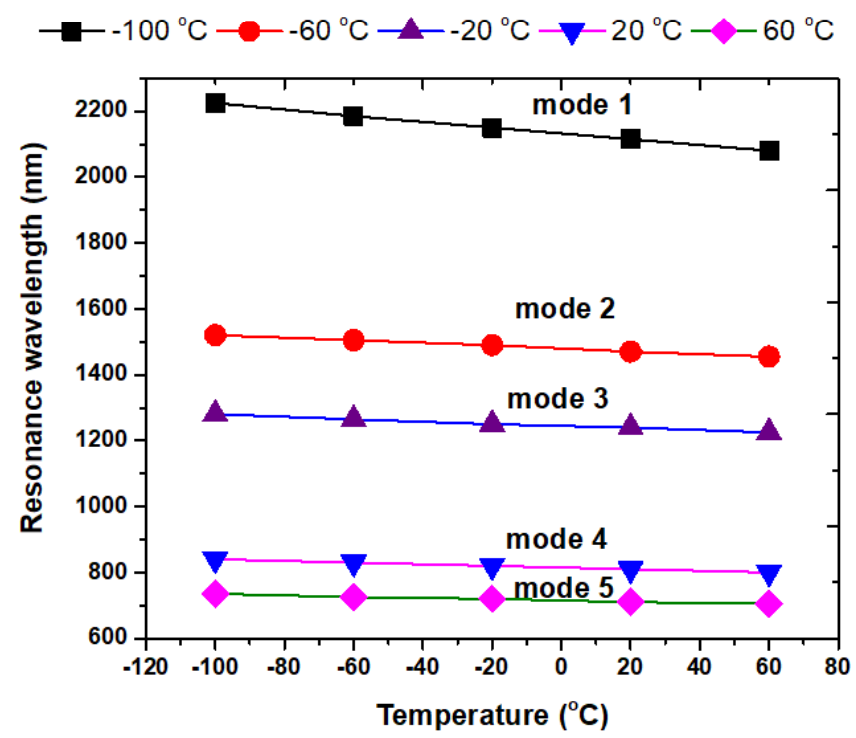
Figure 8. The resonance wavelength spectrum of the proposed case 4 structure at various ambient temperatures ( T ), with the other parameters remaining unchanged from Table 2.